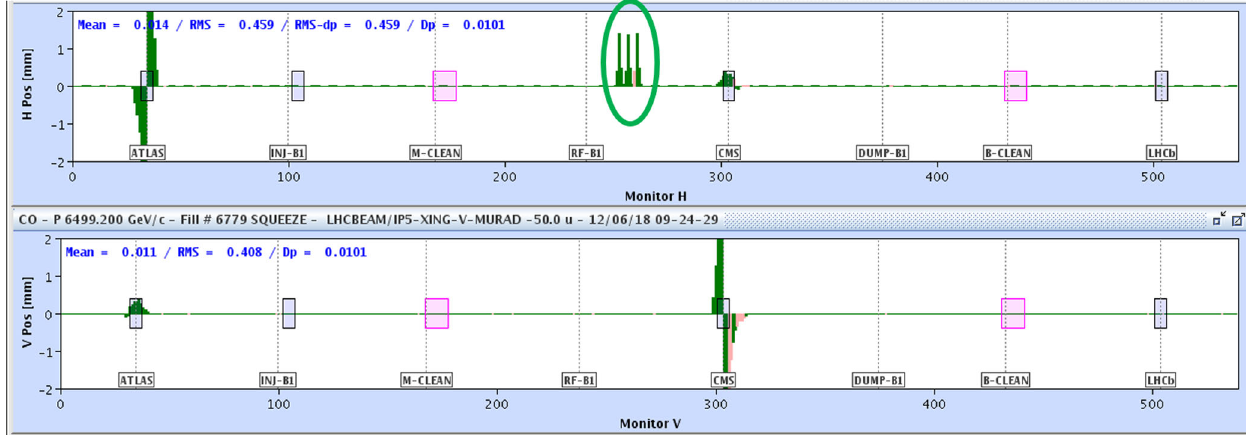
FIG. 11. 2018 flat ATS MD: closed orbit measured for Beam 1 (against a ref. flat orbit) after optics correction. The crossing plane is horizontal in ATLAS and vertical in CMS, i.e., rotated by 90 deg. with respect to the nominal configuration. A new type of β -beating knob ( 3 π H orbit bump) is deployed in sector 45.